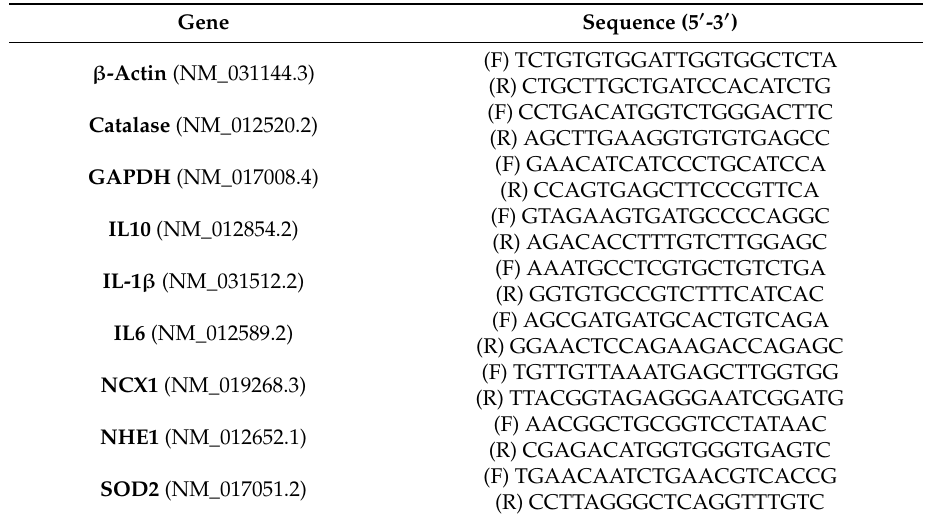
Table 2. Real-time PCR primers used in this